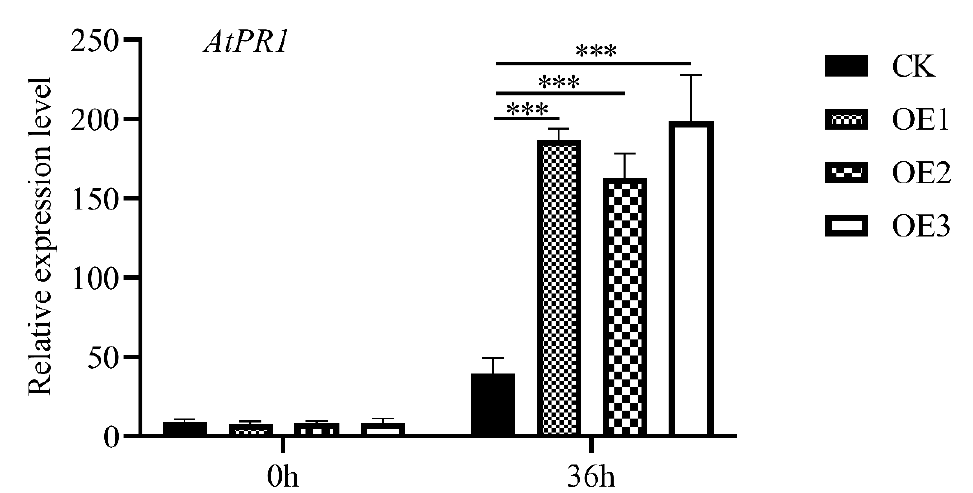
Figure 8. Relative expression of AtPR1 gene in transgenic Arabidopsis before and after inoculation with B. cinerea . CK, empty vector transgenic; OE, MnASI1 transgenic. Error bars represent standard deviation, n = 3 (*** p -value < 0.001; two-tailed t -test).